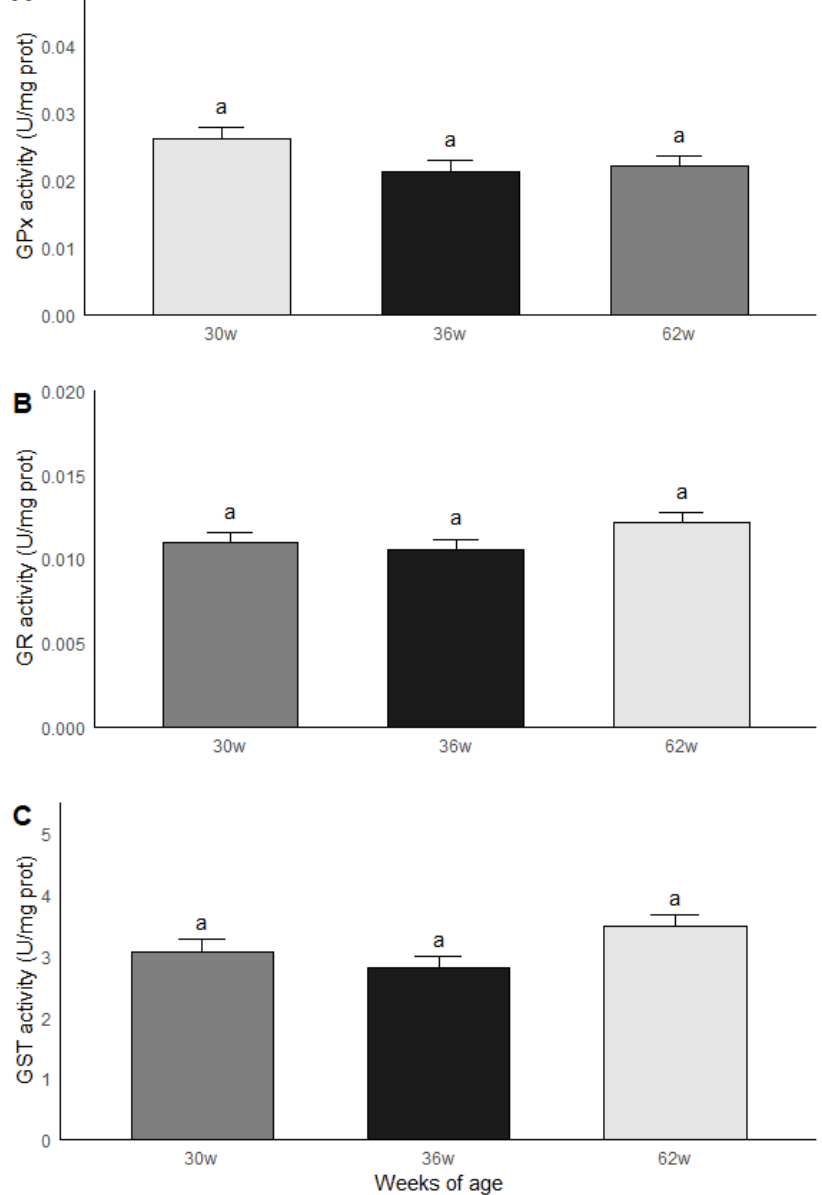
Figure 5. GPx ( A ), GR ( B ) and GST ( C ) activities in testicular parenchima of roosters af 30, 36 and 62 weeks of age. a Equal literals - no significant statistical difference were found between the age groups for the GPx, GR and GST activities. Data are mean ± SEM of measurements by duplicate.